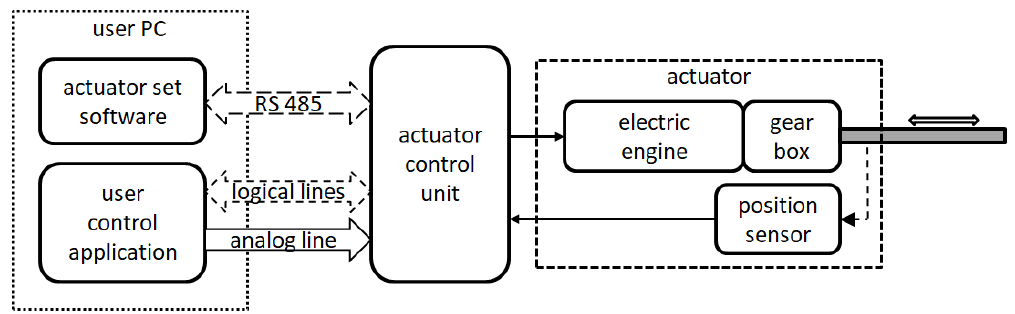
Figure 3. Block diagram of the basic actuator connection.